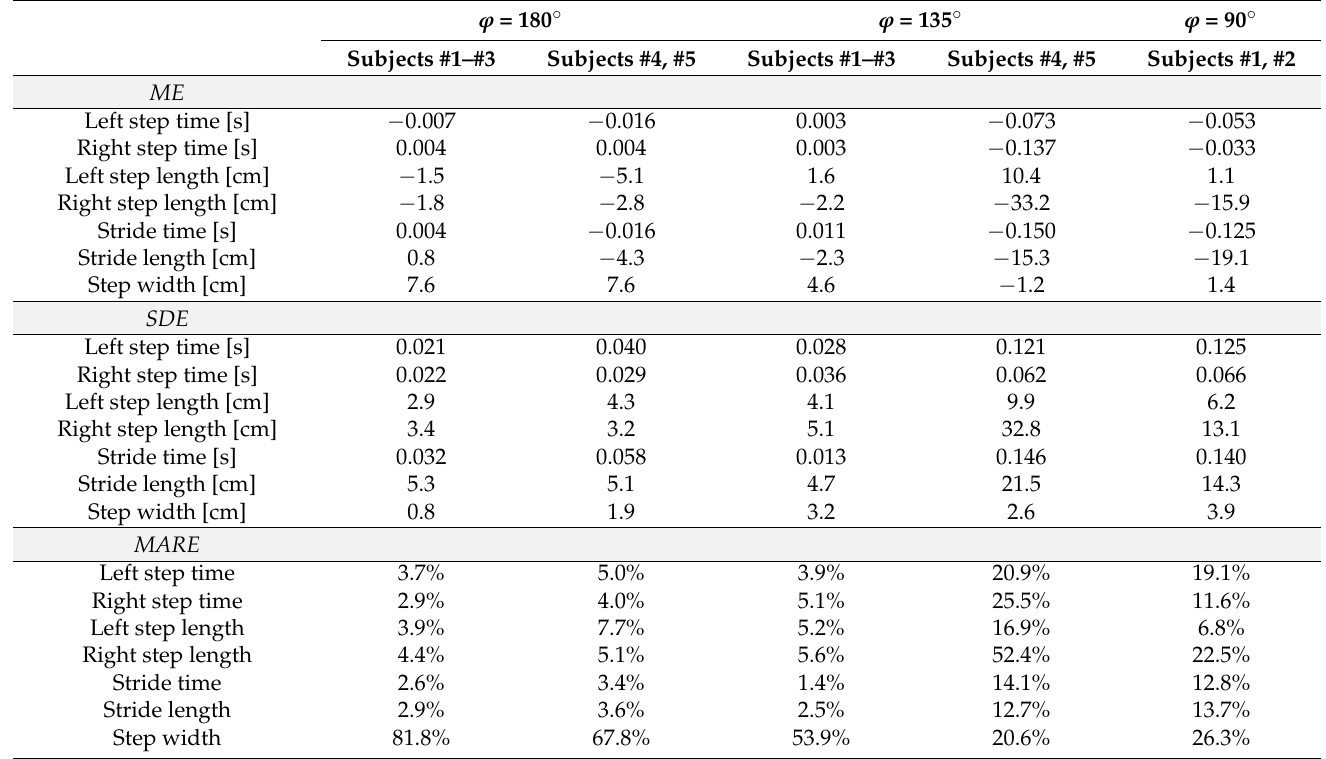
Table A2. The indicators of accuracy of the estimates of spatiotemporal gait parameters, obtained using the KD method.